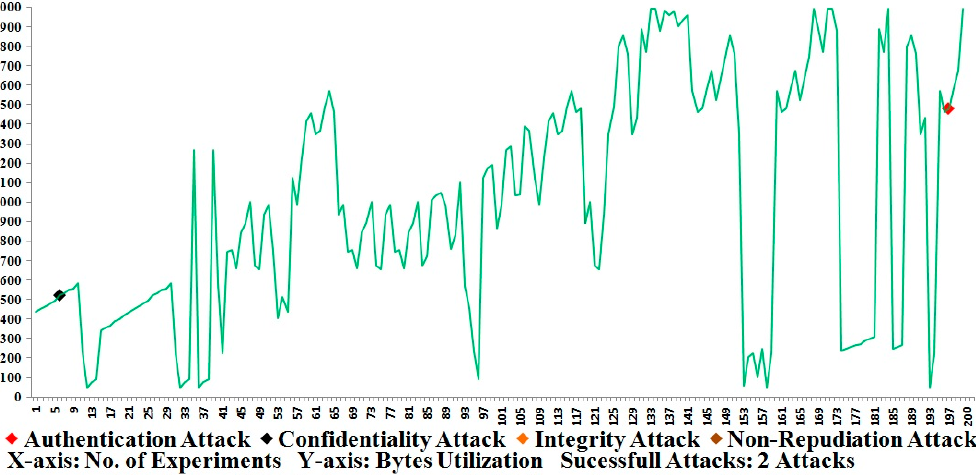
Figure 9. Security test using embedded DNP3 security.